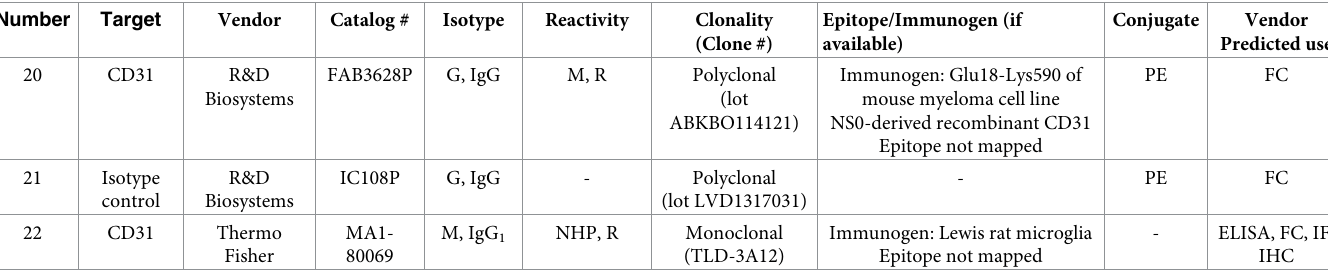
one-way analysis of variance (ANOVA) was used for comparisons involving three or more samples. Post-hoc analyses were performed using the method of Tukey. Data are presented as mean ± SE. P < 0.05 was used to define statistical significance. Initial data review of immuno- cytochemistry, immunofluorescence, and flow cytometry experiments was performed by a blinded investigator whenever possible. At least three technical or biological replicates were used per experiment. For colocalization, data were measured in at least 3 cells/field in at least 3 randomly-selected fields/technical replicate.